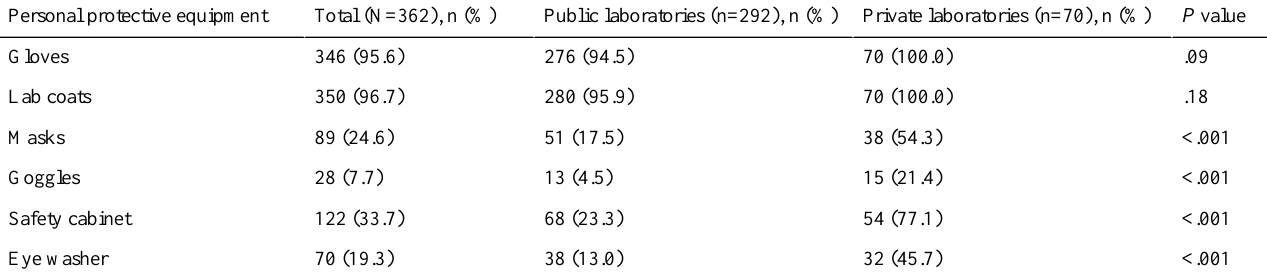
Table 3. Availability of personal protective equipment in public and private laboratories.